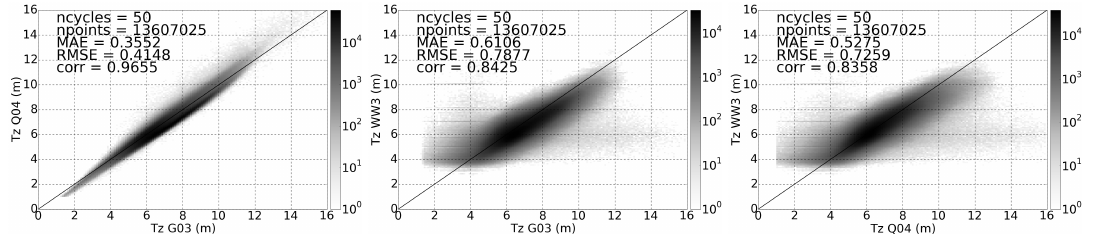
Figure 3. Statistical analysis of mean wave period algorithms G03, Q04 and the Tz derived from numerical wave model WW3 (from left to right), for the first 50 cycles of Jason-1 with swell ratio < 0.9